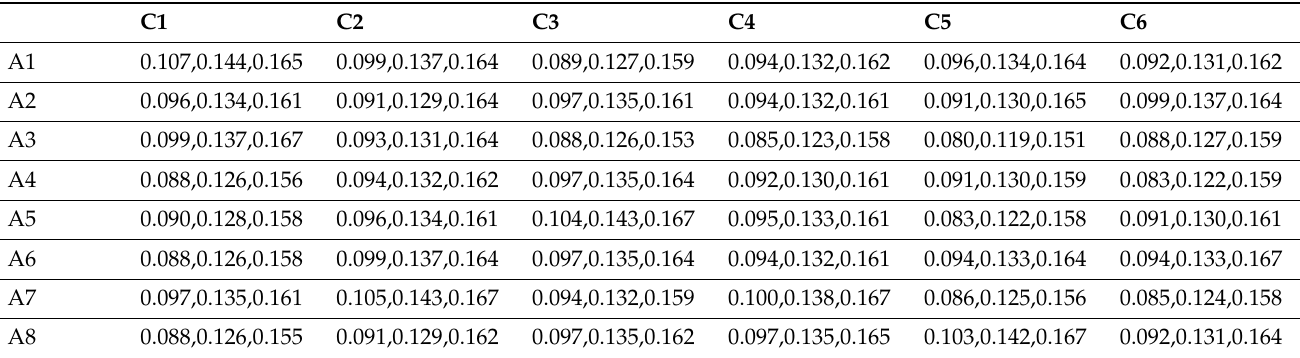
Table 5. The weighted normalized decision